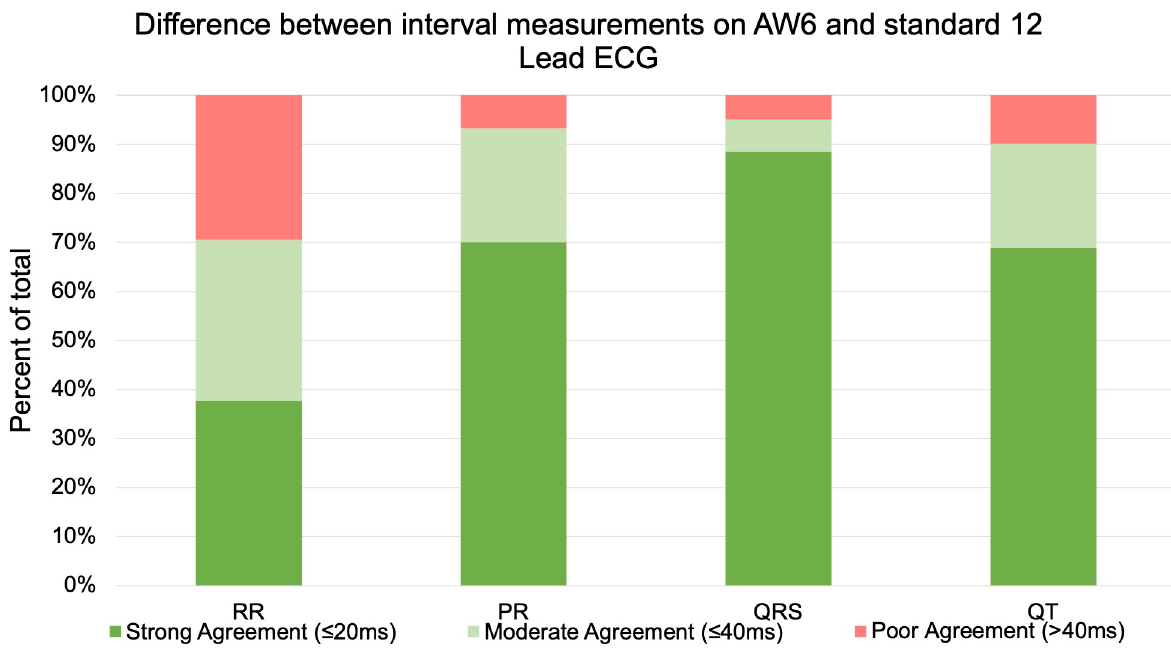
Fig 4. Level of agreement in different ECG intervals between AW6 and 12-lead ECG.